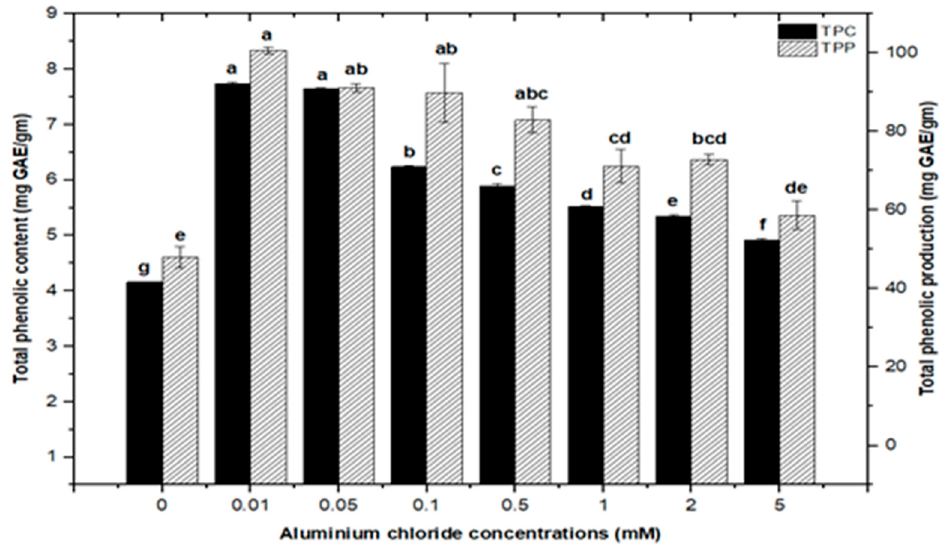
Figure 4. Total phenolic contents and phenolic production of F. indica calli elicited with seven different concentrations of aluminum chloride and control. All the values are mean ± SE. Bars labeled with different letters (LSD values) exhibit significant variation ( α < 0.05).